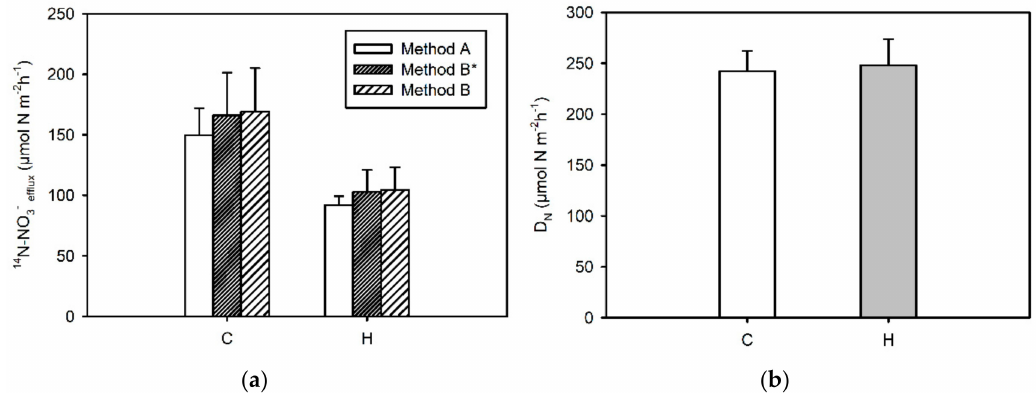
Figure 7. 14 N-NO 3 − -e ffl ux ( a ) and rates of denitrification of 14 N-NO 3 − produced within sediments via nitrification (D N , b ) measured in intact cores incubated in the dark. Method B * refers to calculations reported in [17] (Equation (7)) excluding the natural abundance of 15 N in the sedimentary ammonium pool. The group C ( n = 4) had riverine sieved sediments whilst the group H ( n = 4) had sieved sediments added with the oligochaete S. tamesis (800 ind m − 2